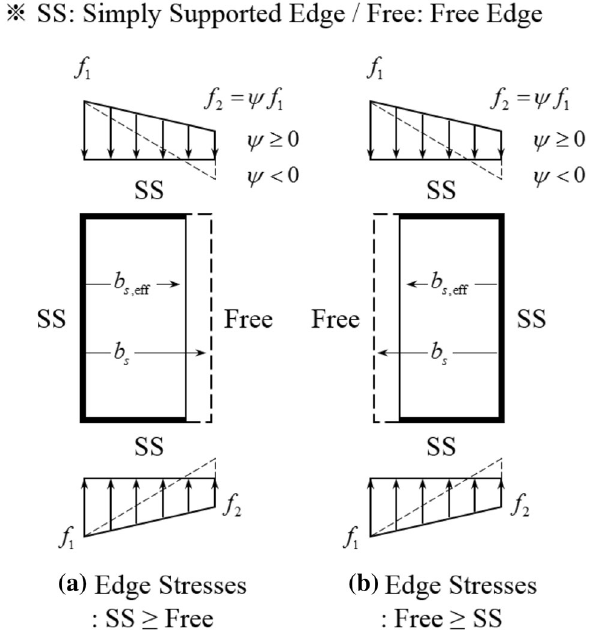
Fig. 8 Effective leg of steel angles after local